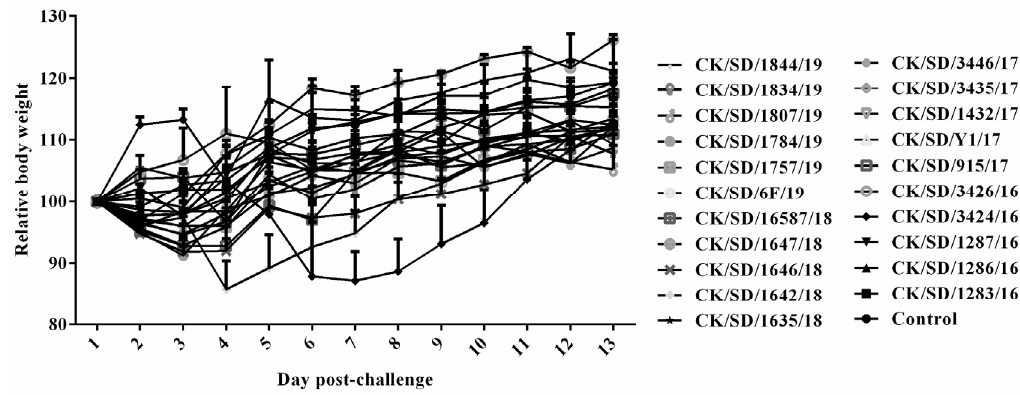
Figure 3. Body weight changes of mice. The values represent the average body weights compared to the baseline weight and standard deviations from five mice. Relative weight loss. Mice were intranasally inoculated with 10 6 EID 50 of virus or diluent (mock). The body weights of five inoculated mice were measured daily and are represented as the percentage of the weight on the day of inoculation (day 0). Six-week old female BALB/c mice were used in all experiments and were observed for 14 days post infection.